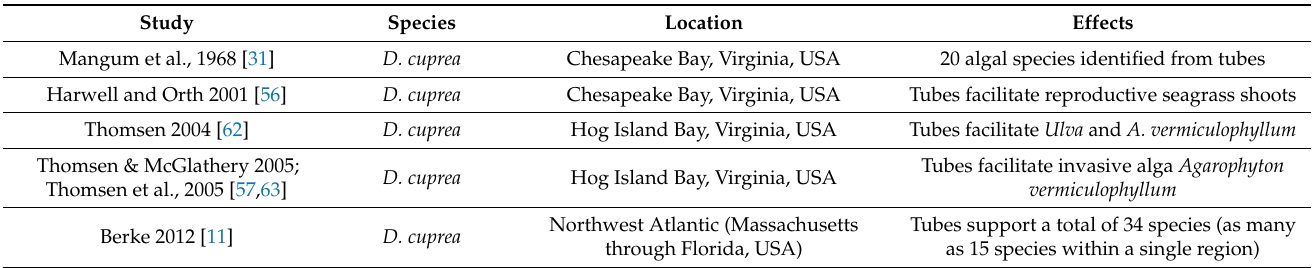
Table 1. Studies quantifying Diopatra facilitation of algae and